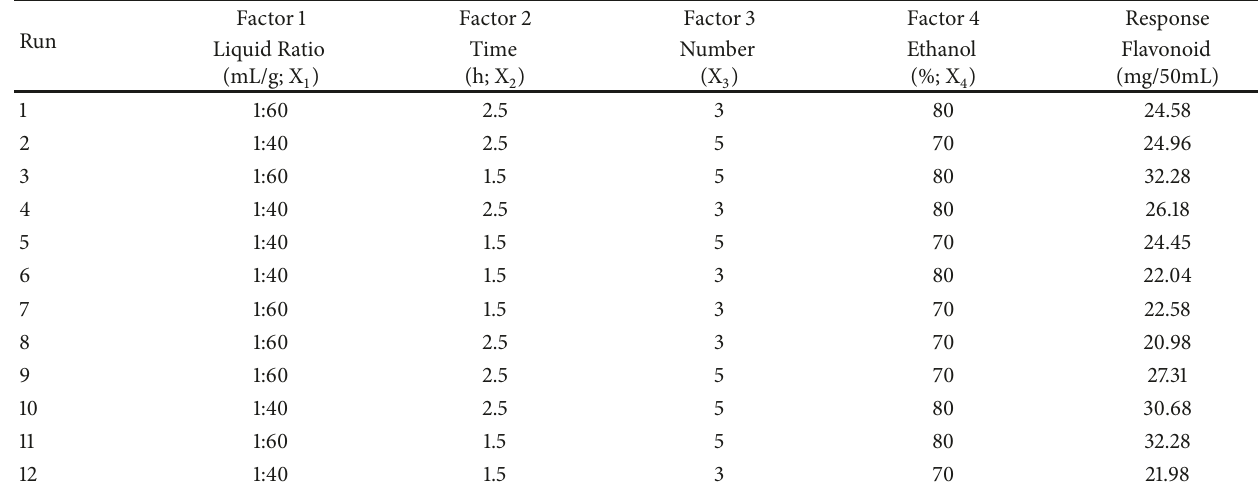
Table 1: PBD and